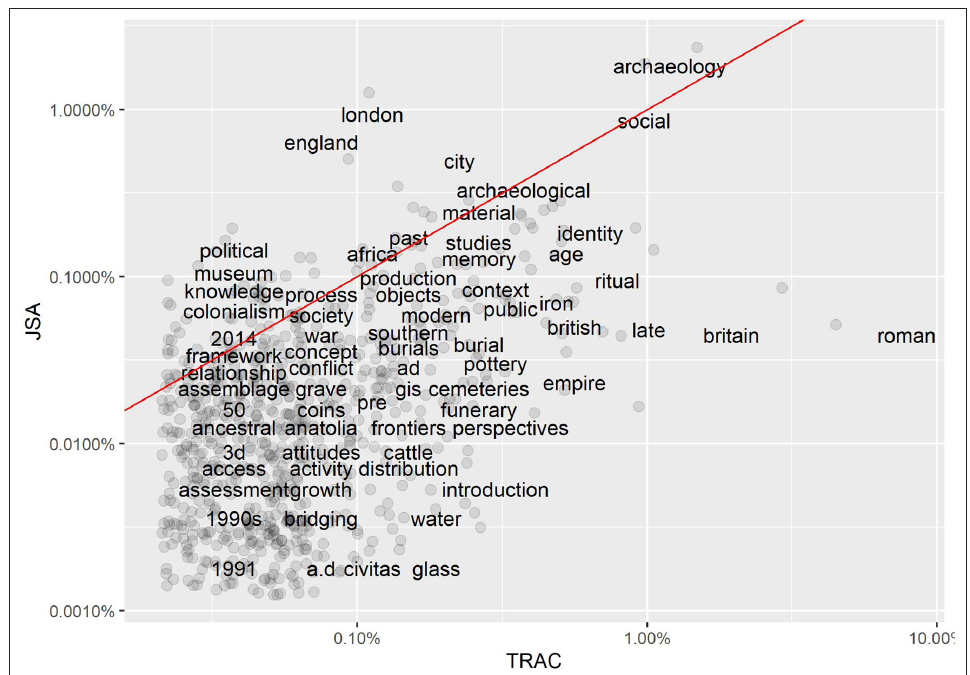
Figure 16: Frequency comparison plot of words used in article title – TRAC and Journal of Social Archaeology